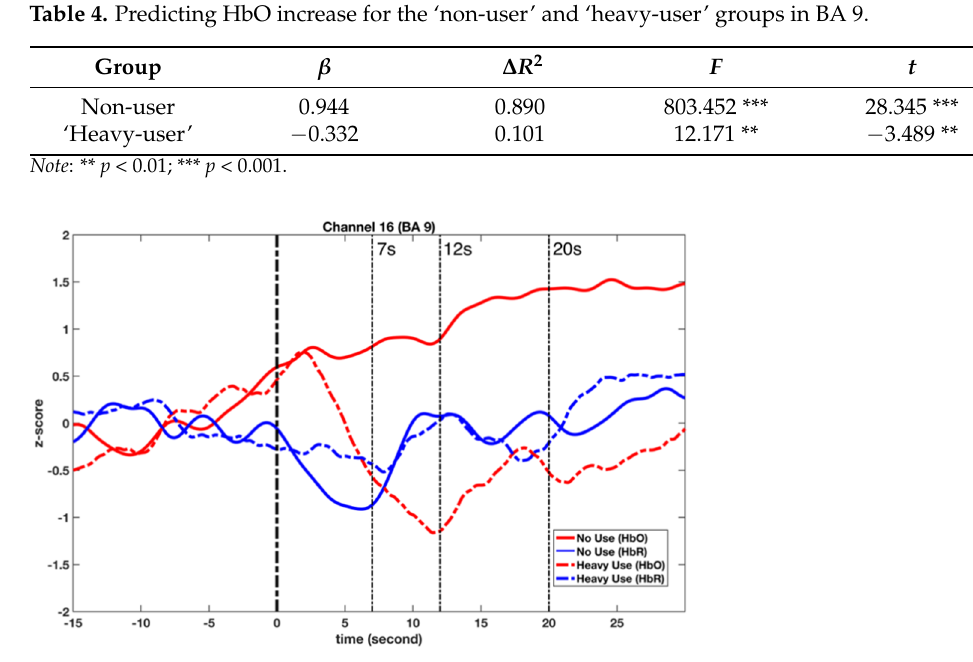
Figure 6. Observed changes in the HbO and HbR concentration in BA 9 (ch 16) during the DCCS tasks.